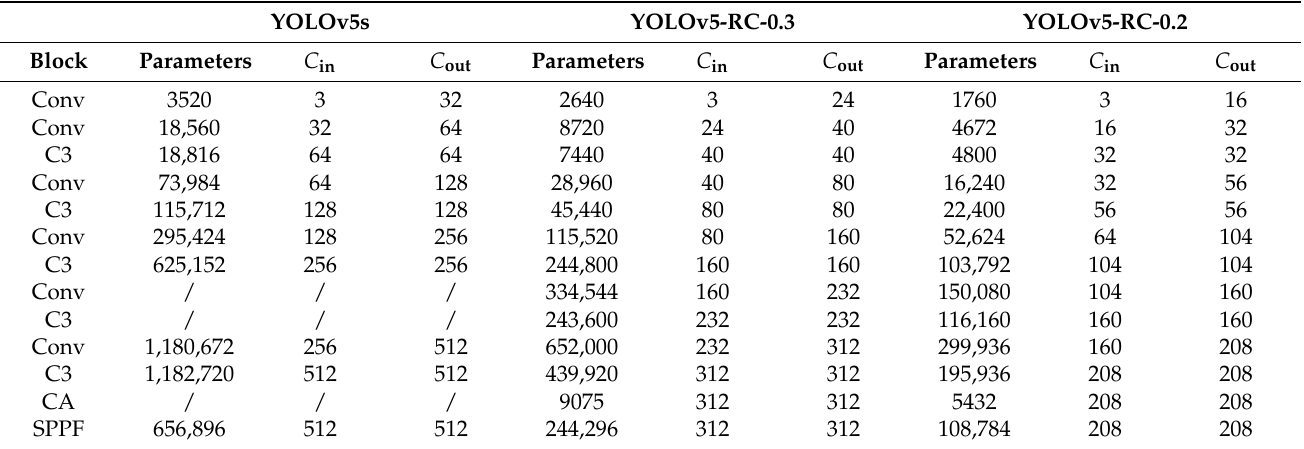
Table 1. Comparison of the parameters of the modules in backbone after reducing the number of channels of YOLOv5s by 40% and 60%